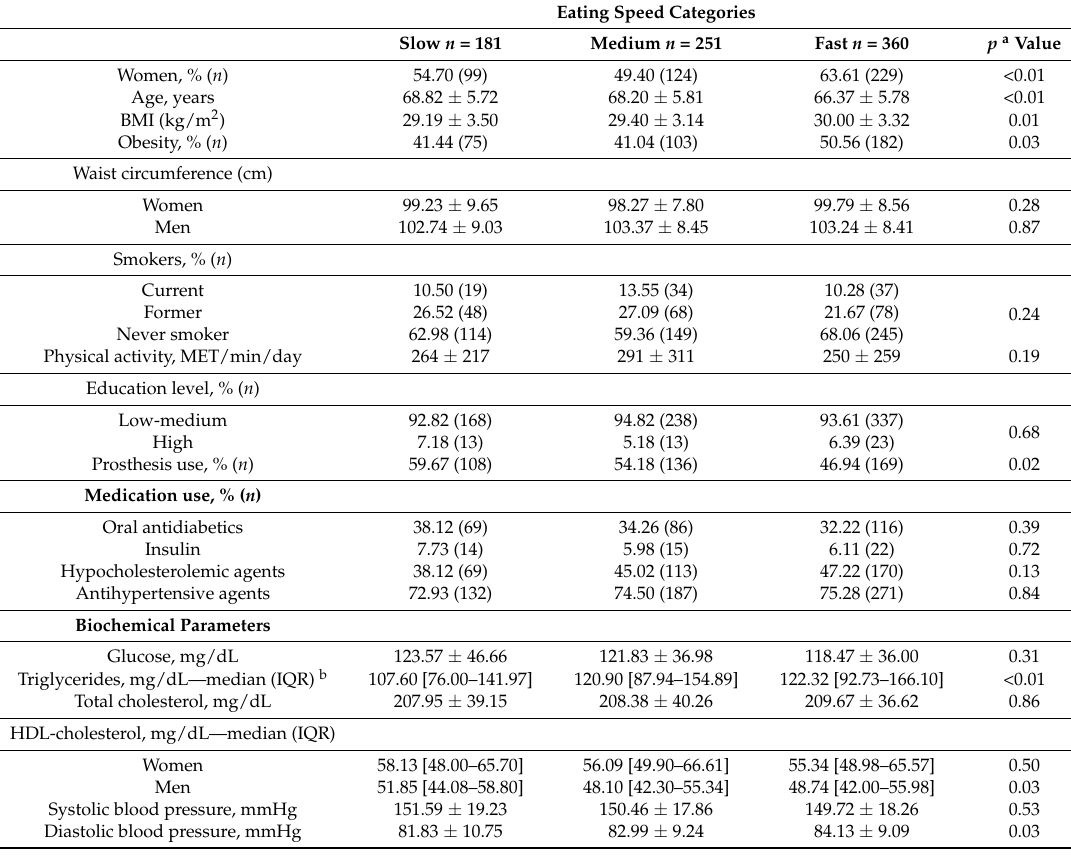
Table 1. General characteristics of the study population across self-reported eating speed categories.